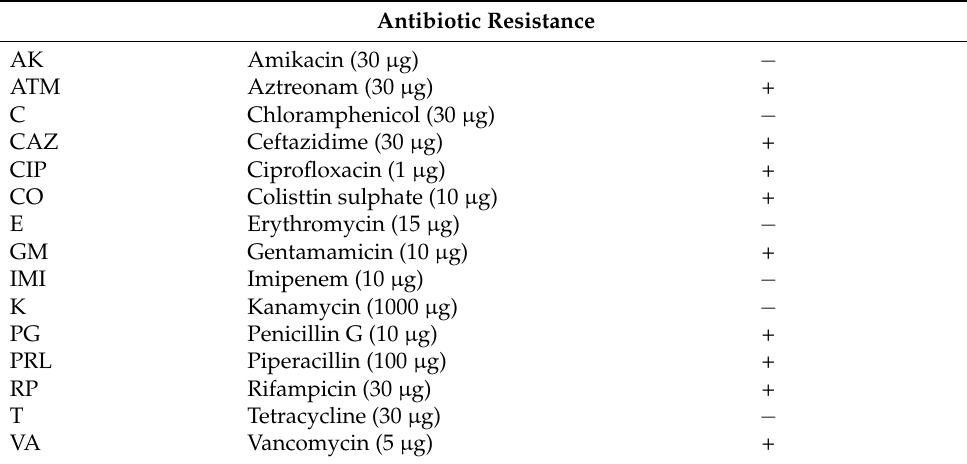
Table 5. Antibiotic resistance status of Streptomyces sp. strain